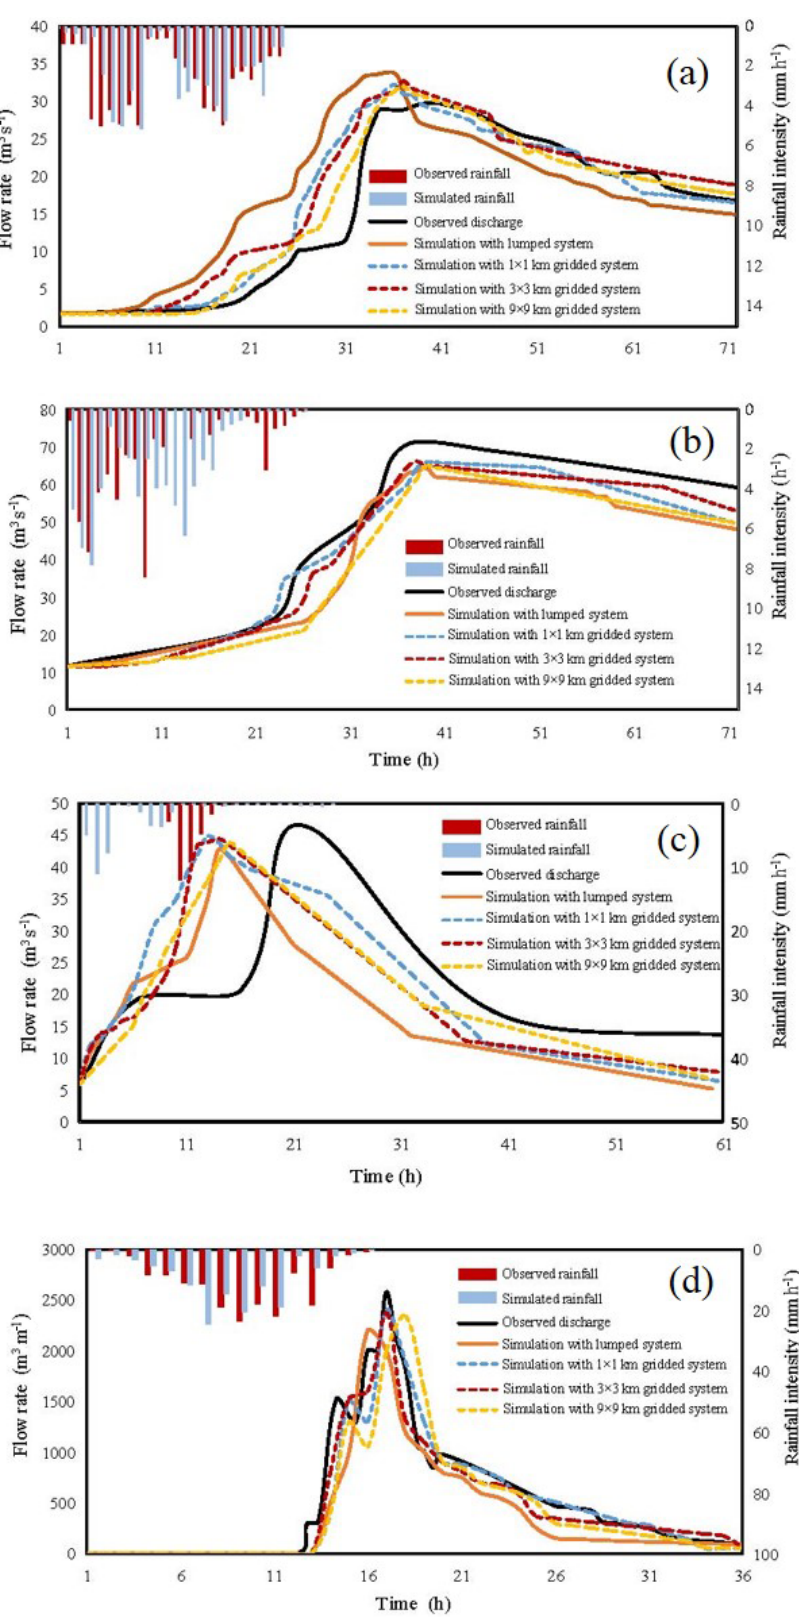
Figure 11. Flood process simulations of the coupled atmospheric–hydrologic systems for the four storm events: (a) event 1 in Fuping, (b) event 2 in Fuping, (c) event 3 in Fuping, and (d) event 4 in